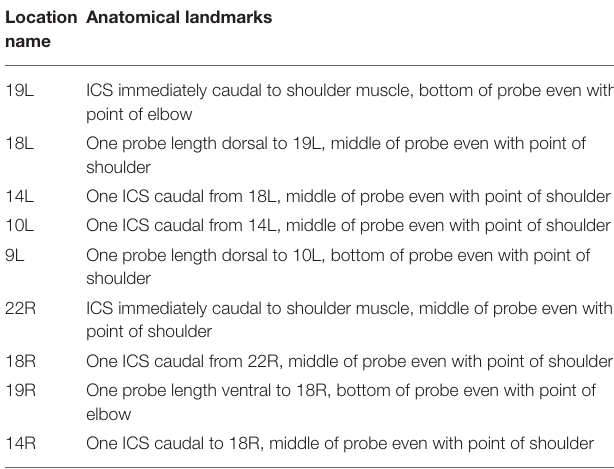
TABLE 1 | Anatomical landmarks associated with each ultrasound